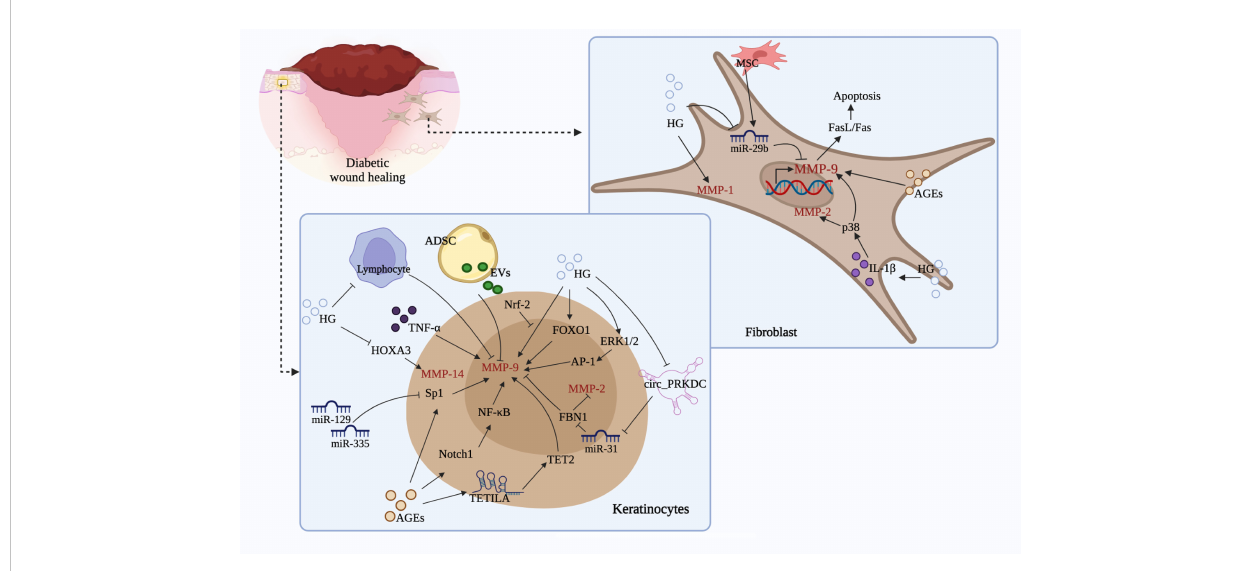
FIGURE 4 Regulation of MMPs by different cell types and related mechanisms. (Stimulated by HG and AGEs, keratinocytes and fi broblasts could produce a large amount of MMP-9, MMP-2, MMP-1 and MMP-14, which leads to decreased activity and migration, and ultimately causes impaired wound healing. During this process, signals such as miRNAs, lncRNAs, circRNAs, ERK1/2, FOXO1, HOXA3, Sp1, Notch, NF- k B, p38, FasL/Fas, and cells like ADSC, MSC, as well as lymphocyte are involved, which may promote or slow down the production of the above mentioned MMPs and thus affect diabetic wound